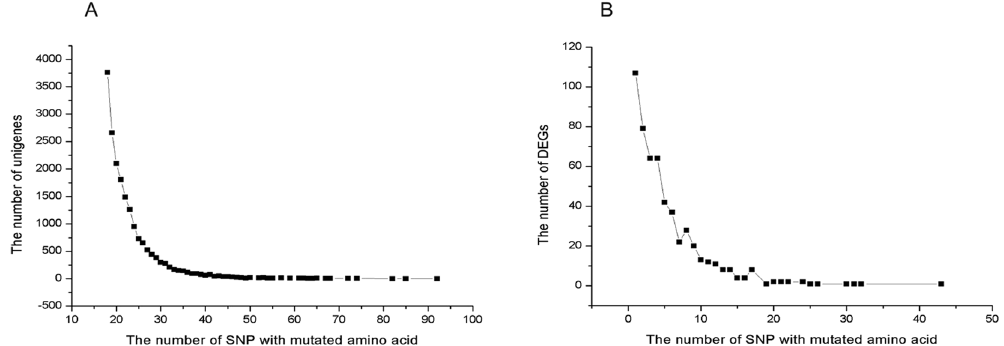
Figure 5. Satistics of SNP sites with mutated amino acid and unigenes included those SNP sites ( A ); Satistics of differentially expressed unigenes (DEGs) included SNP sites with mutated amino acid and those SNP sites ( B